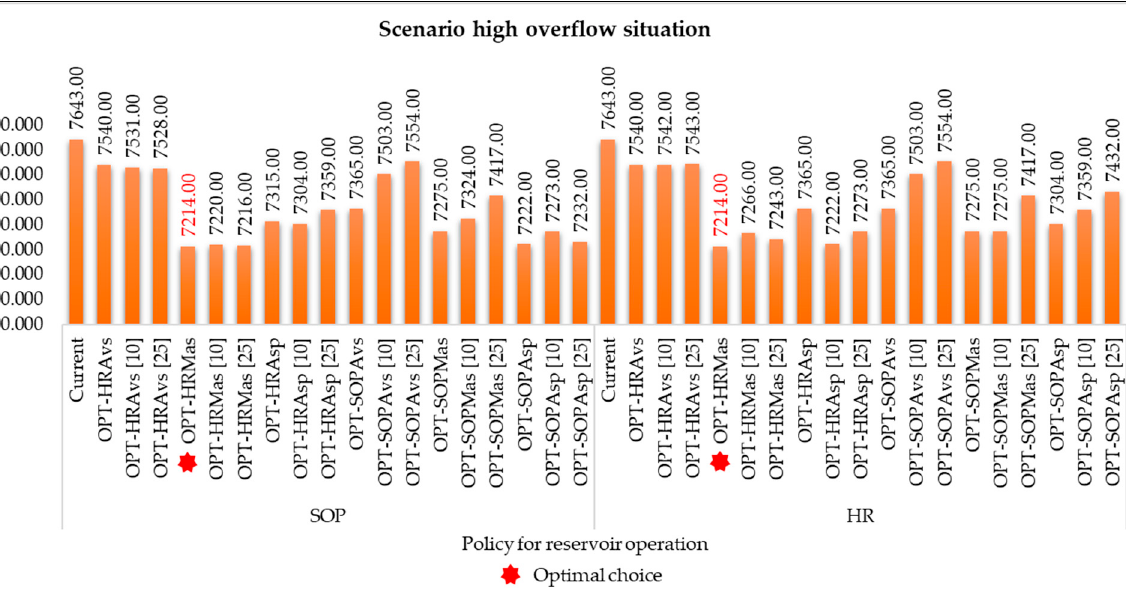
Figure 10. Optimal choice for operating rule curves under typical overflow situation.